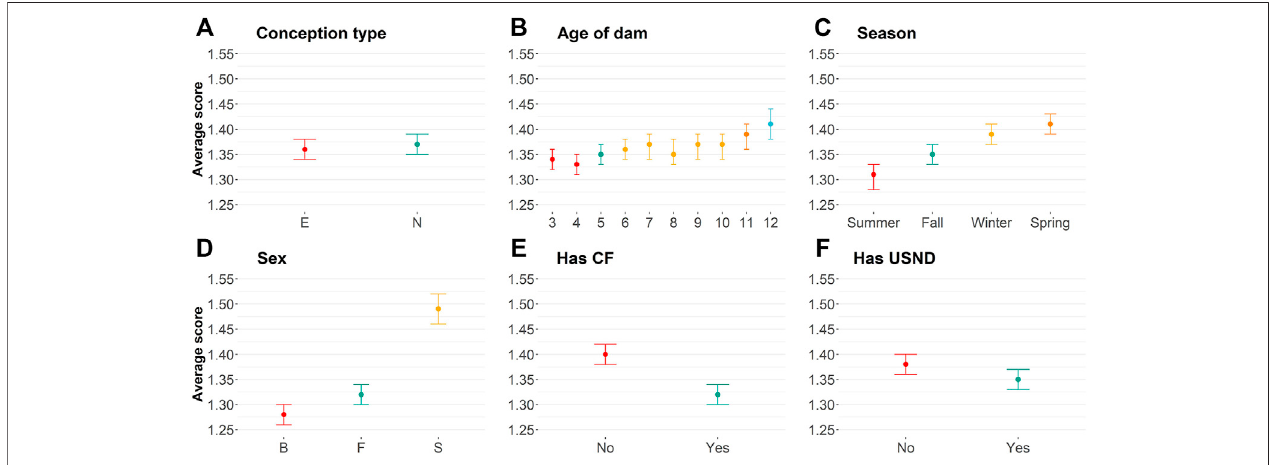
FIGURE 1 | Average of temperament score using least-square means for (A) conception type [naturally conceived (N) or embryo transference (E)]; (B) Age of the dam in years; (C) : birth season; (D) : sex [bull (B), steers (S), and female (F)]; (E) if the animal was creep-fed; and (F) : if the animal had ultrasound